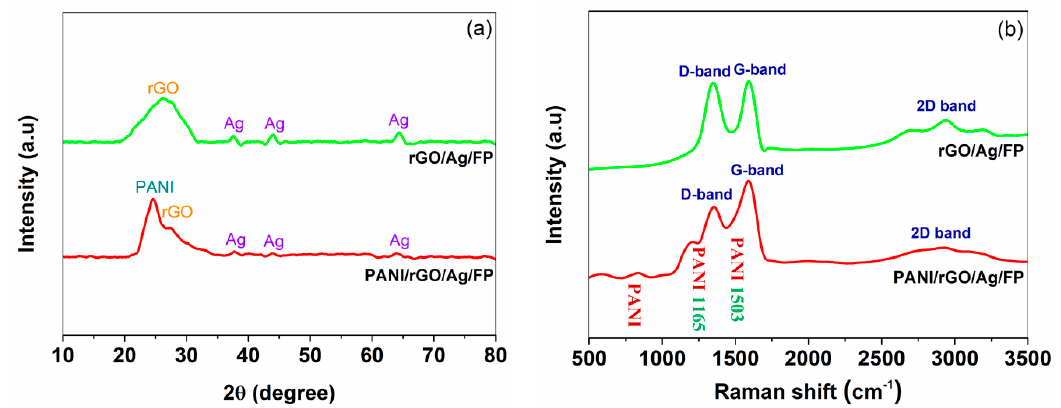
Figure 2. ( a ) XRD patterns of rGO/Ag/FP and PANI/rGO/Ag/FP electrodes, respectively. ( b ) Raman spectrum of rGO/Ag/FP and PANI/rGO/Ag/FP electrodes, respectively.